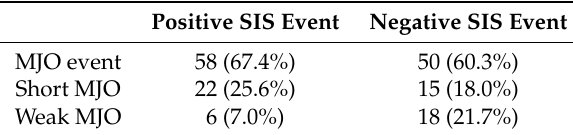
Table 1. Categorization of positive and negative SIS events according to MJO